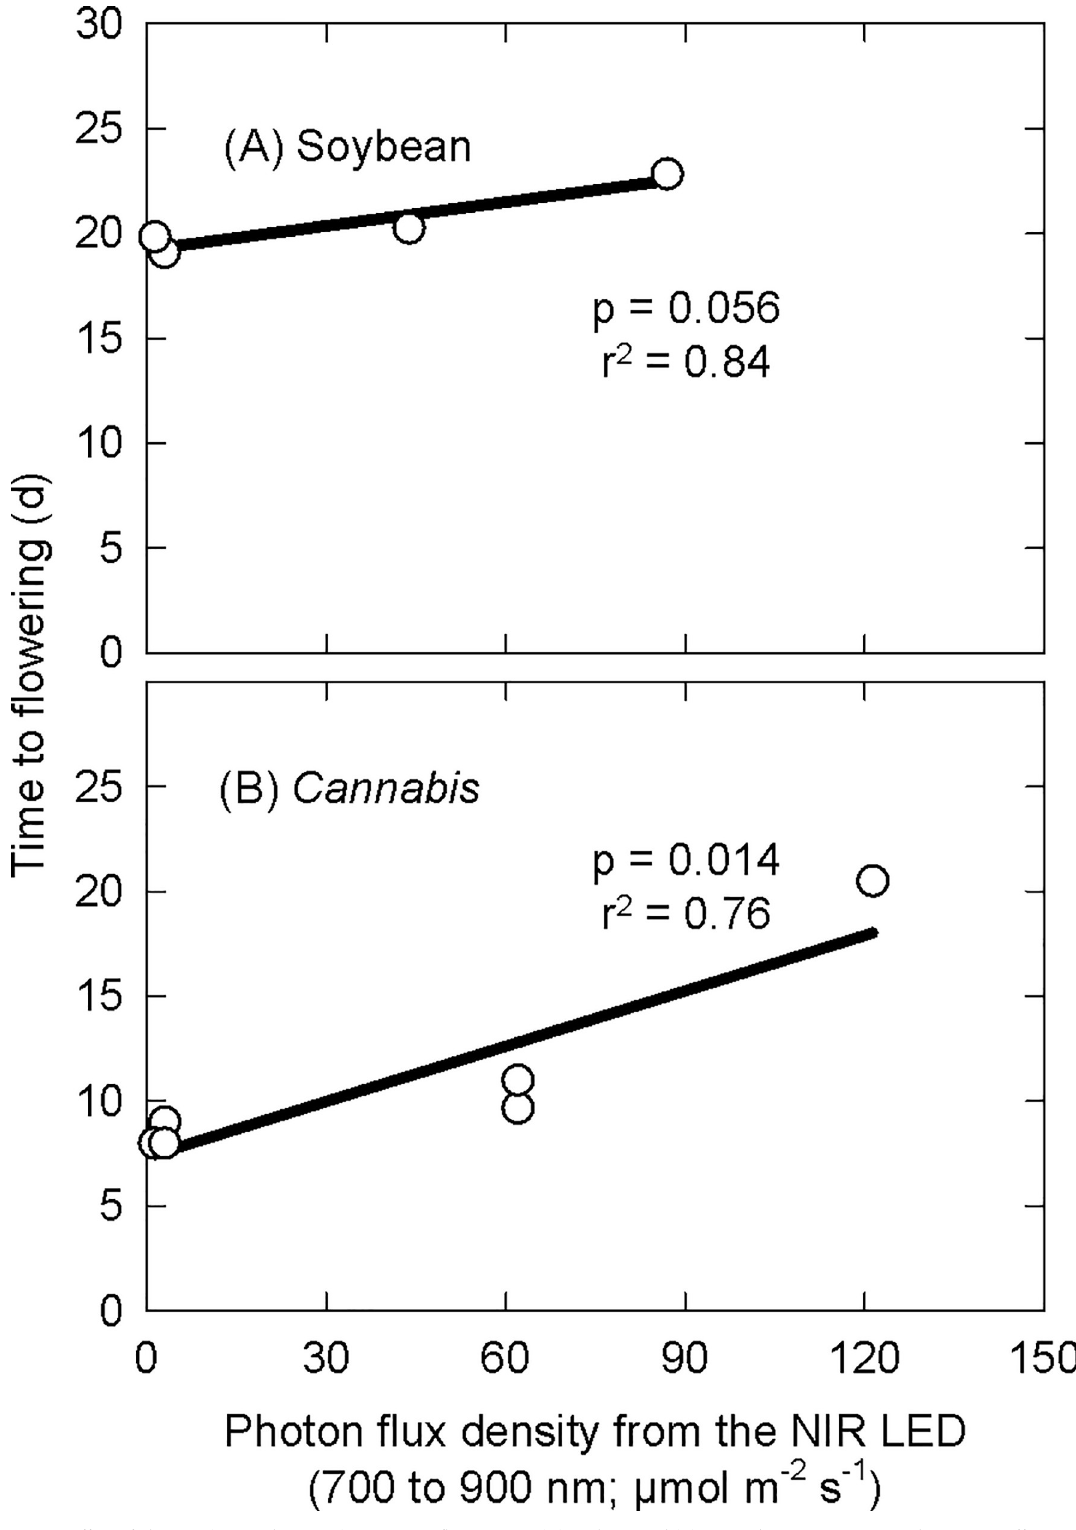
Fig 4. Effect of photons (700 and 900 nm) on time to flowering in (A) soybean and (B) Cannabis . Data points are the average effect within each treatment.